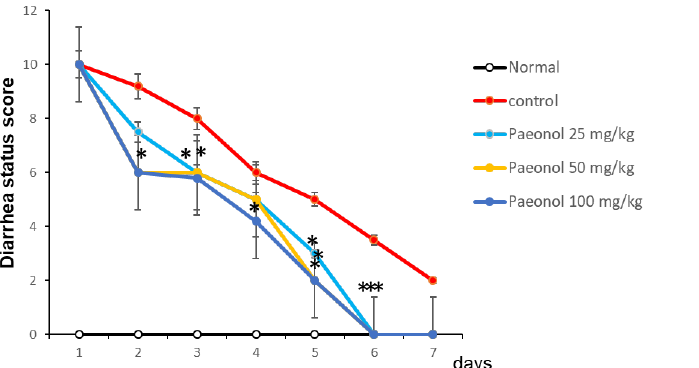
Figure 9. Effects of paeonol administration on body weight ( top ), water intake ( middle ), and diarrhea status ( bottom ).